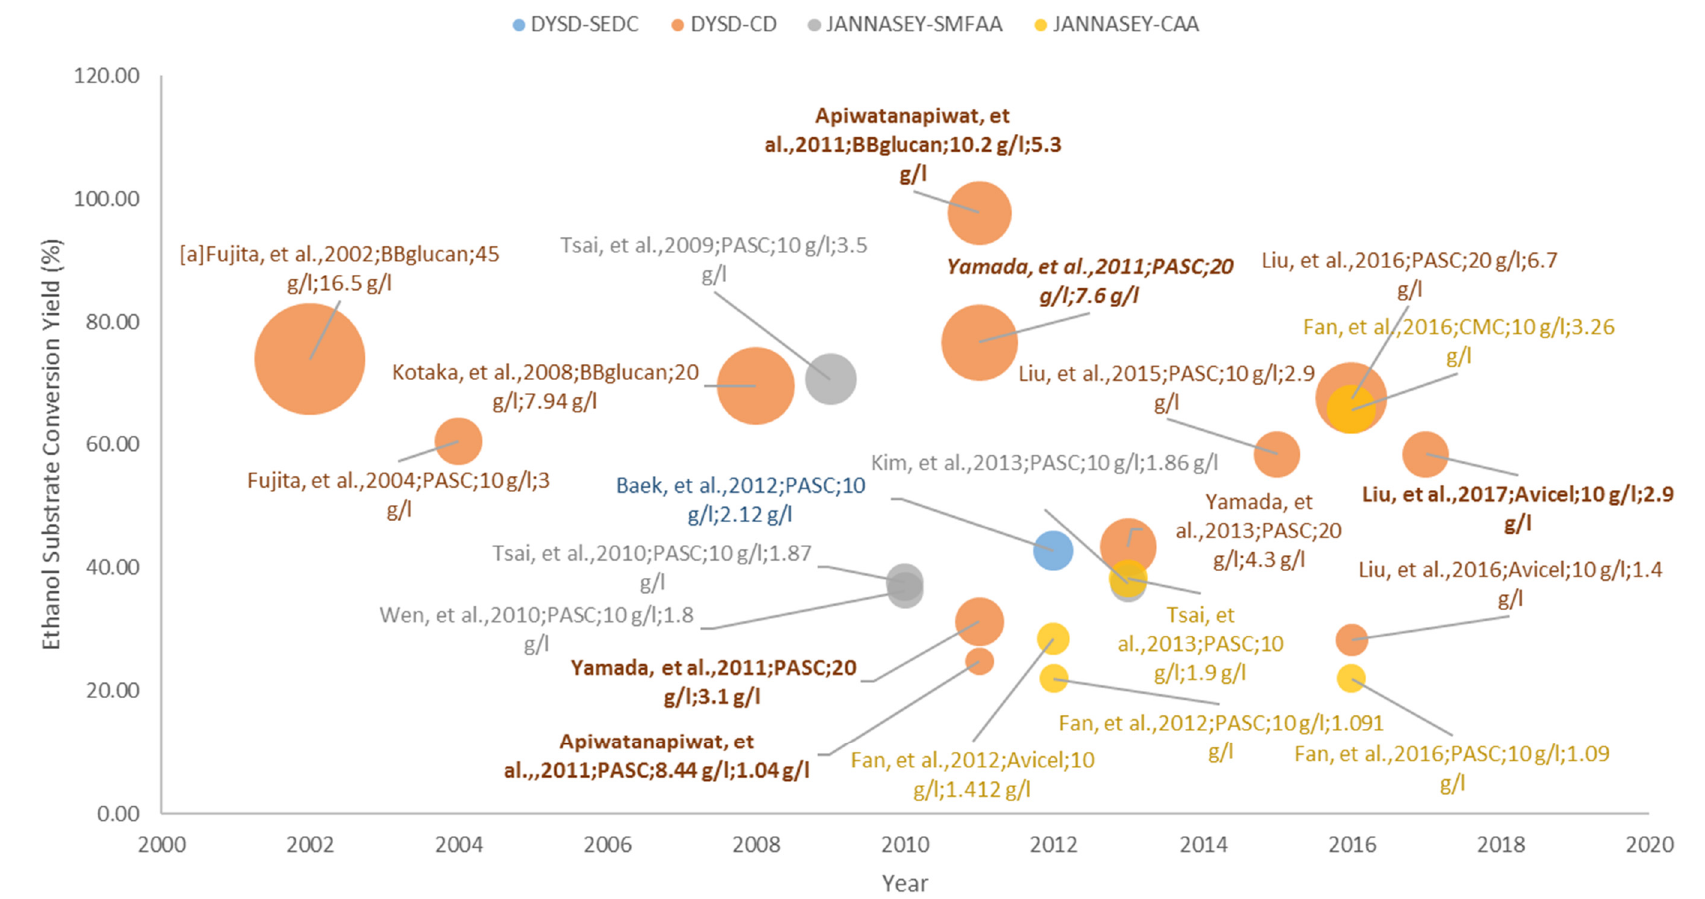
Figure 6. Visualization of the status and development of yeast surface display for Cellulosic Bioethanol Production. Bubble sizes represent ethanol titer. Data labels are formatted as follows: (Reference (author-date); Substrate; Substrate Concentration; Ethanol Titer). For the DSYD-CD data set: labels in boldface represent cellulase ratio control via delta-integration; labels in italic represent utilization of diploid host strains.